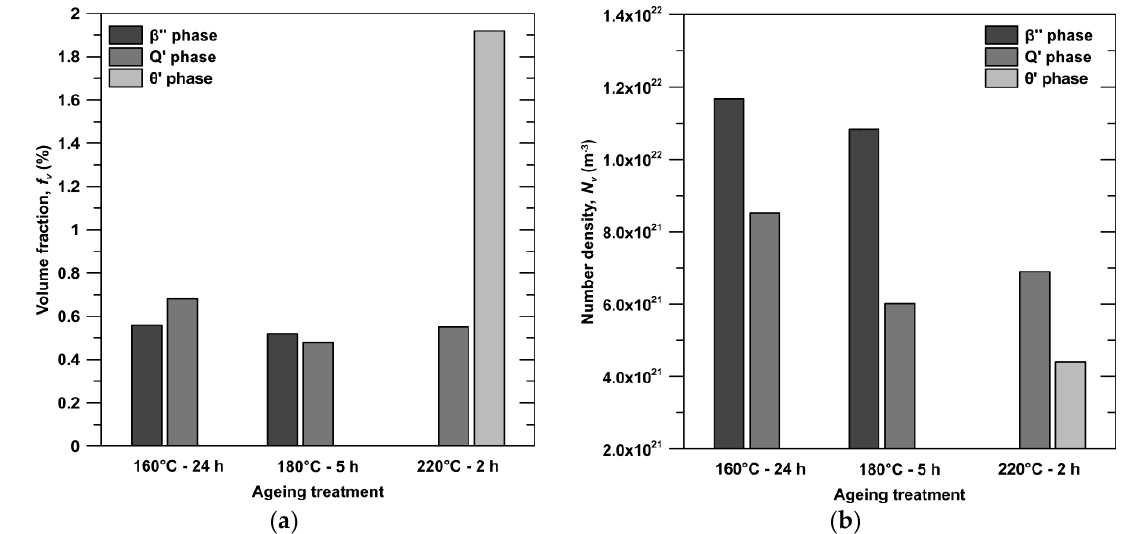
Figure 17. ( a ) Calculated volume fraction and ( b ) number density per unit volume of the phases observed by TEM investigation at the different peak ageing conditions. observed by TEM investigation at the different peak ageing